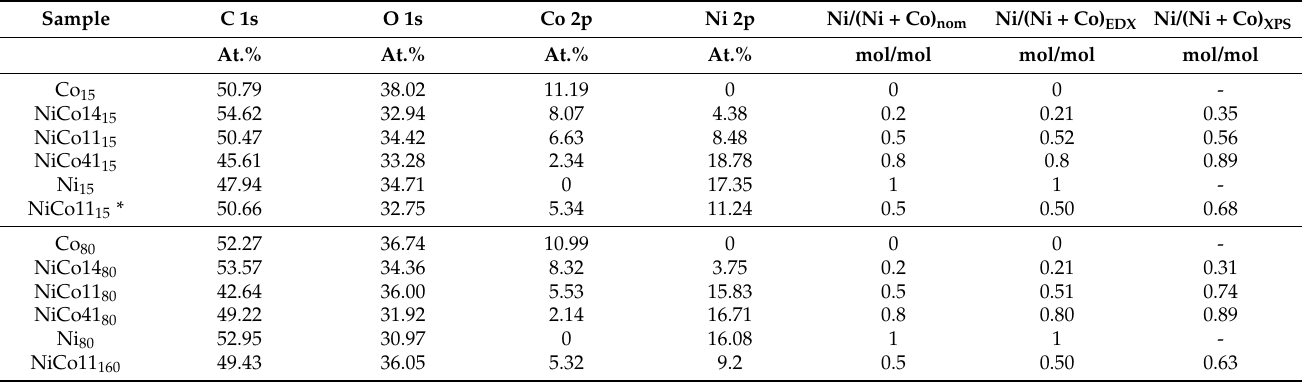
Table 4. Surface concentrations of elements (in at. %) and comparison of the surface (XPS), bulk (EDX), and nominal bulk concentrations expressed as Ni/(Ni+Co) molar